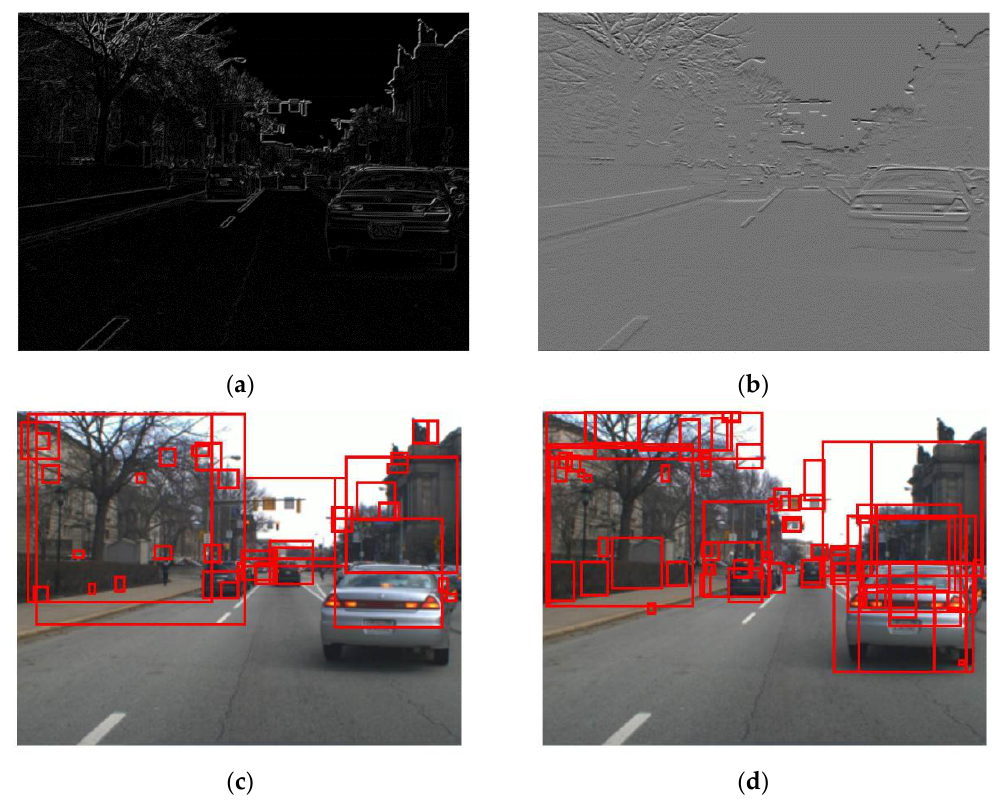
Figure 5. Hypothesis generation methods for VD: ( a ) Absolute edge image by [28]; ( b ) Signed horizontal edge image; ( c ) HG by absolute edge image [28]; and ( d ) HG by signed horizontal edge image.